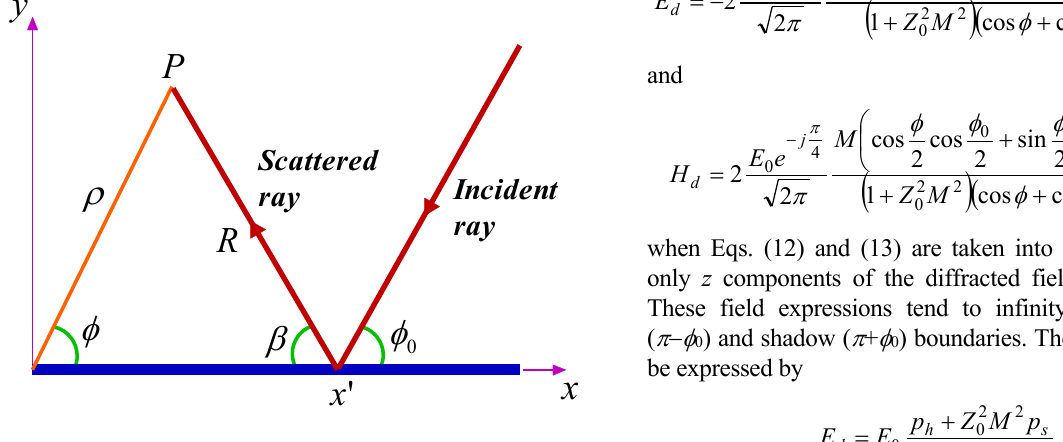
FIGURE 5. The scattering geometry by a